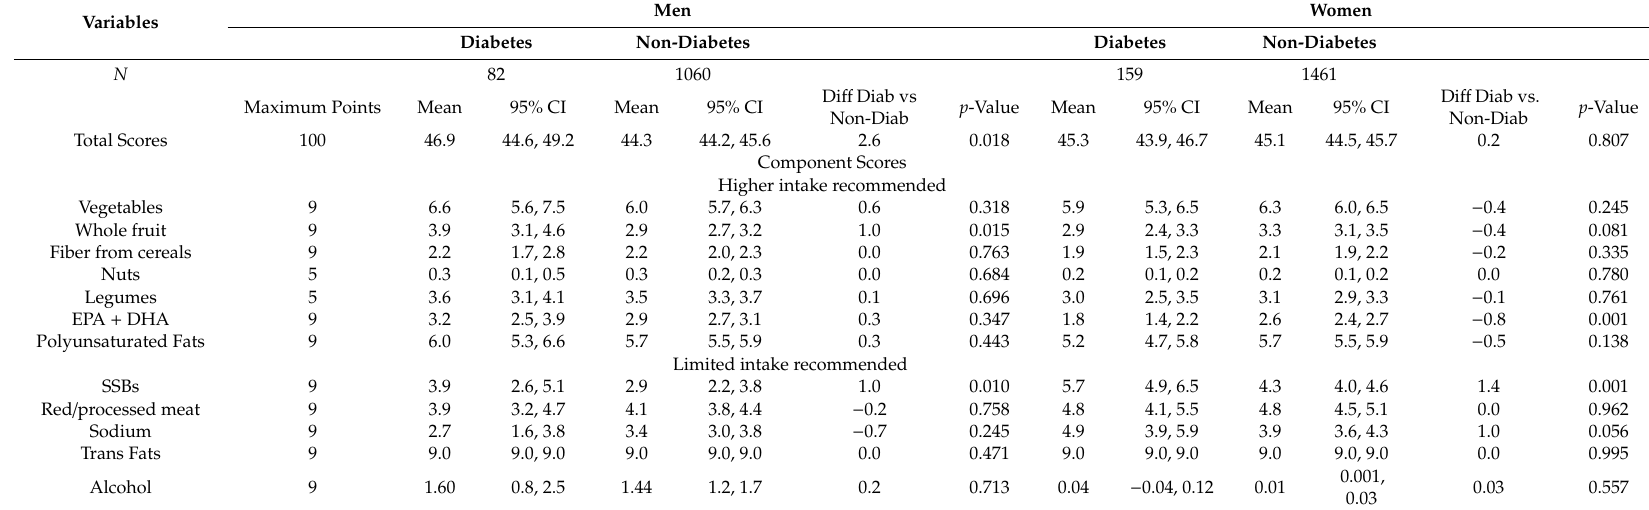
a Sex-specific multivariable linear regression models were used to predict dietary scores according to diabetes status and adjusting for age, hypertension status, body mass index, smoking status, educational level, wealth index, rural / urban area, and geographic region. Estimates were weighted to adjust for unequal probability of sampling and to be